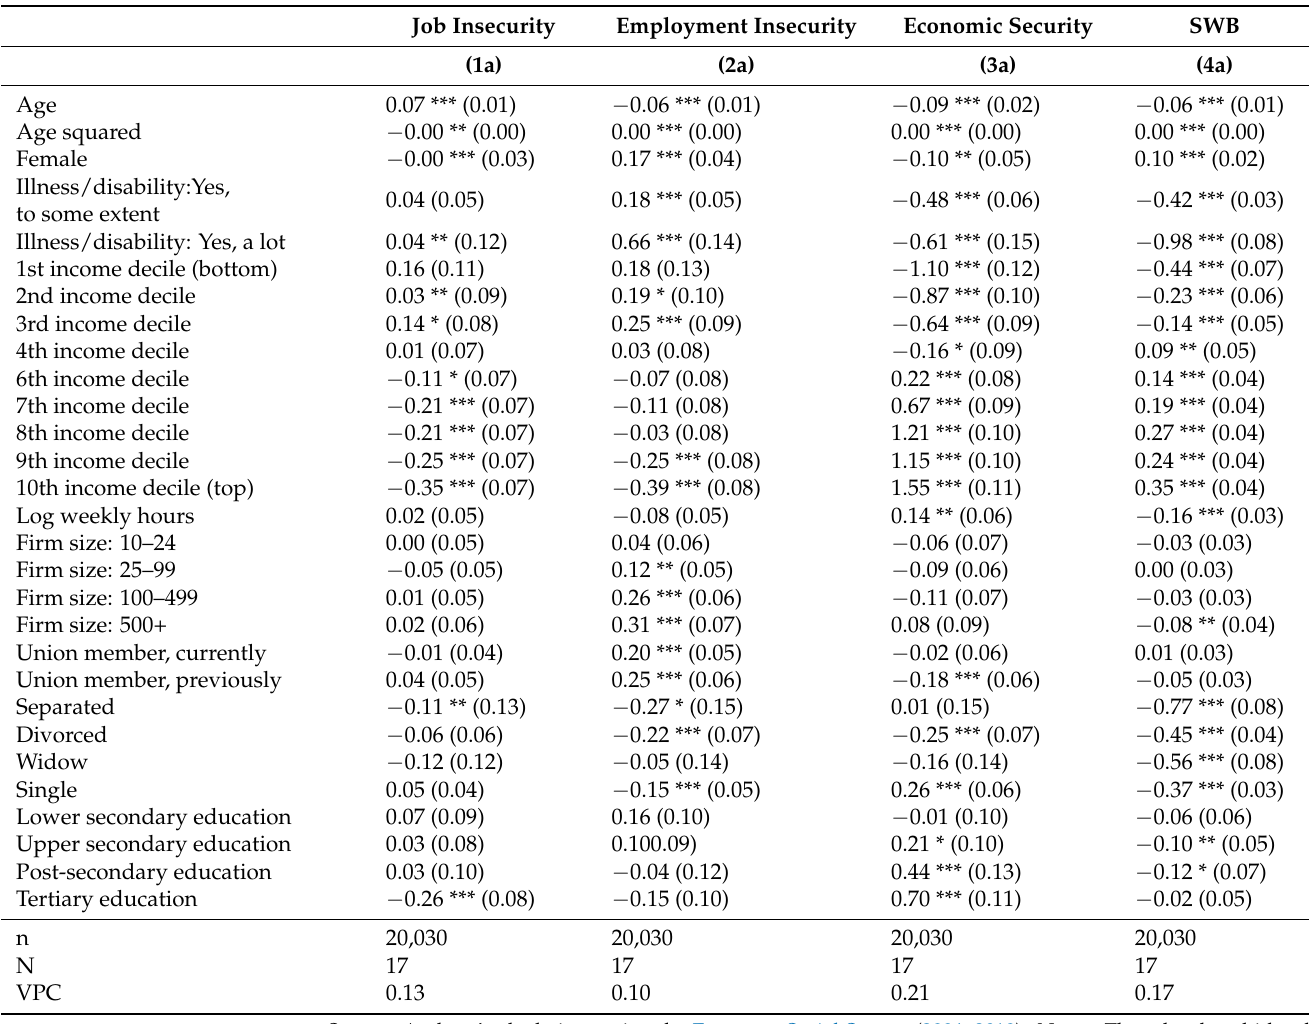
Table A2. Level-2 effects on labor market insecurity and well-being